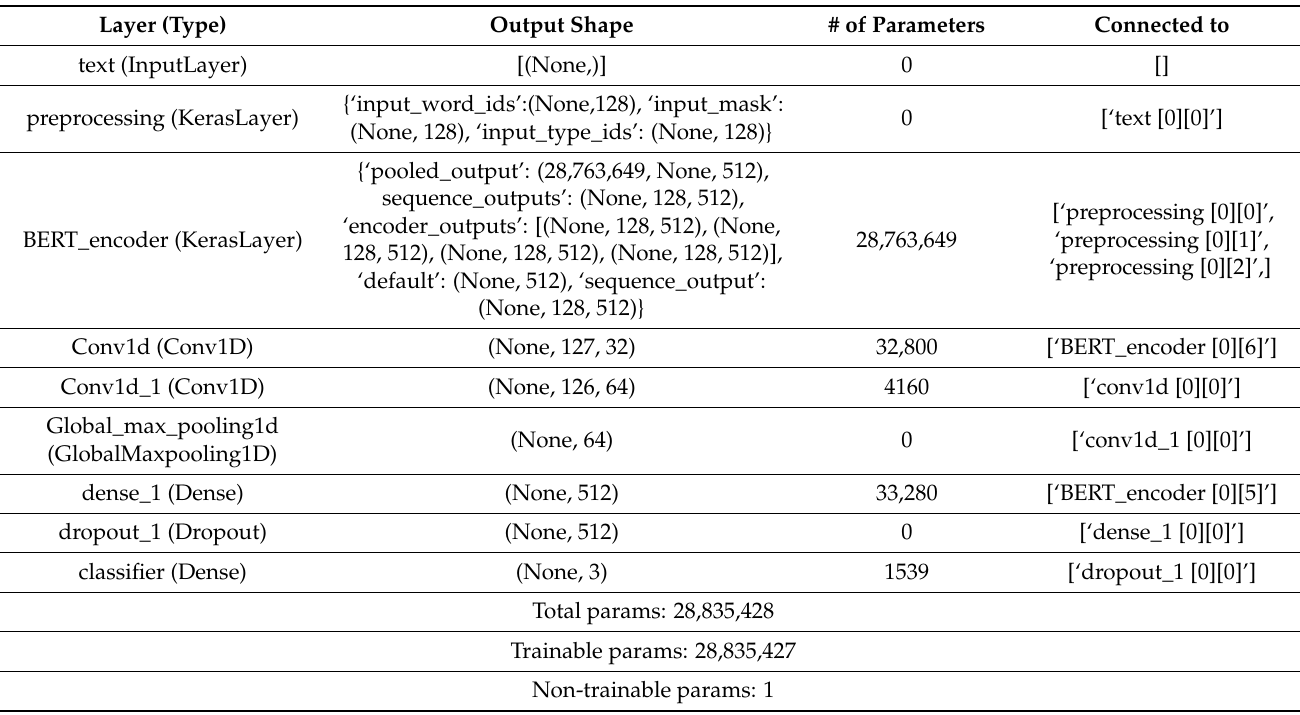
Table 7. BERT + ANN model